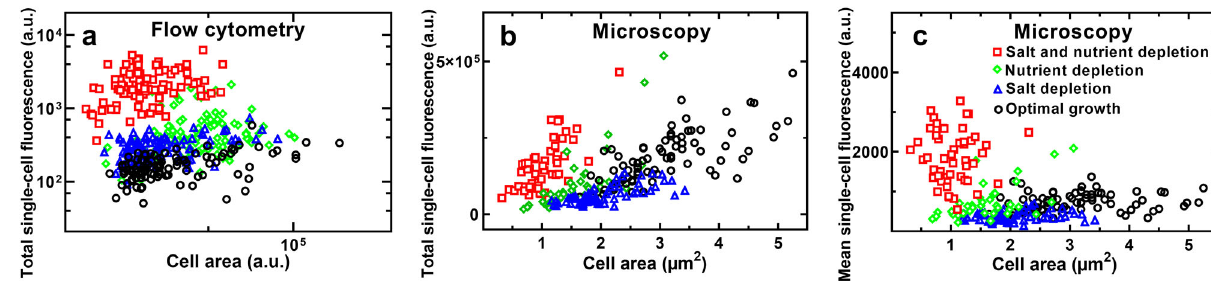
Fig. 3 Glucose accumulation is heterogeneous across variant environments in a cell size-independent fashion. Size dependence of the total intracellular fl uorescence of the glucose analogue 2-NBDG in individual E. coli under optimal growth conditions (circles), nutrient depletion (diamonds), salt depletion (triangles) or combined nutrient and salt depletion (squares) measured after 900 s incubation in 2-NBDG via ( a ) fl ow cytometry and ( b ) microscopy in the mother machine. Pearson correlation coef fi cients of a) 0.35, 0.40, 0.42 and 0.32 and b) 0.71, 0.76, 0.69 and 0.71, respectively (all ****). c Corresponding size dependence of the mean intracellular fl uorescence normalized by cell size. Pearson correlation coef fi cients of 0.18 (ns), 0.57 (***), 0.16 (ns) and − 0.01 (ns), respectively. ns = non signi fi cant, p value > 0.05; *** p value < 0.001; **** p value < 0.0001. N = 100 representative measurements on individual bacteria in ( a ) out of a total N = 50,000 measurements performed in biological triplicates. N > 30 for each experimental condition collated from